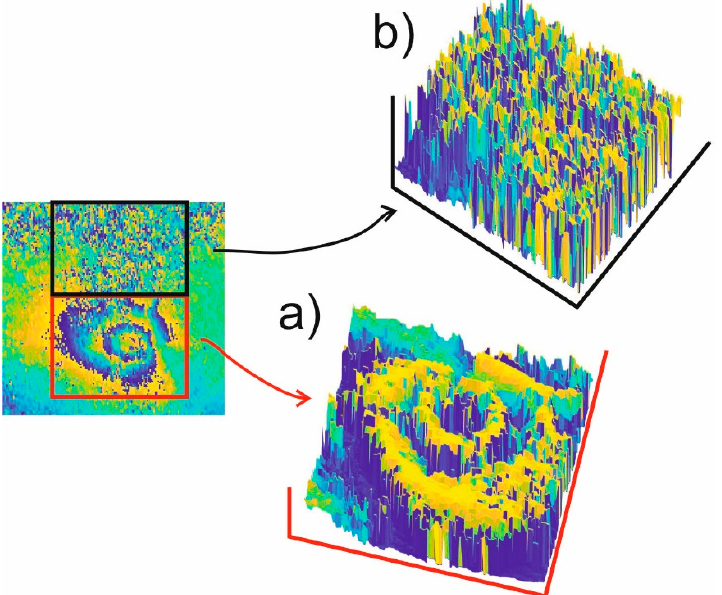
Figure 2. An example of linear monotonic change of the phase value preceded by a step change in its value in interferograms computed from subsidence ( a ) and the random change of the phase value in interferograms characteristic for areas with no subsidence ( b ). The interferogram was computed from radar images taken on 4 April 2017 and 16 April 2017 for the area of Upper Silesia.